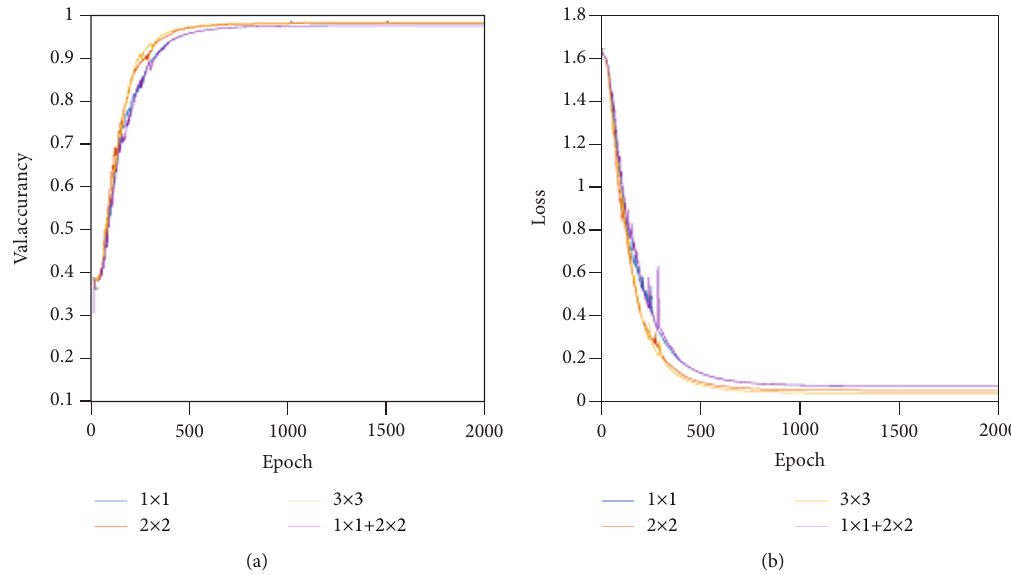
Figure 6: Training history of di ff erent sizes of CNN kernel; (a) accuracy on the validation set; (b) loss curve during training. Each curve is an average of 30